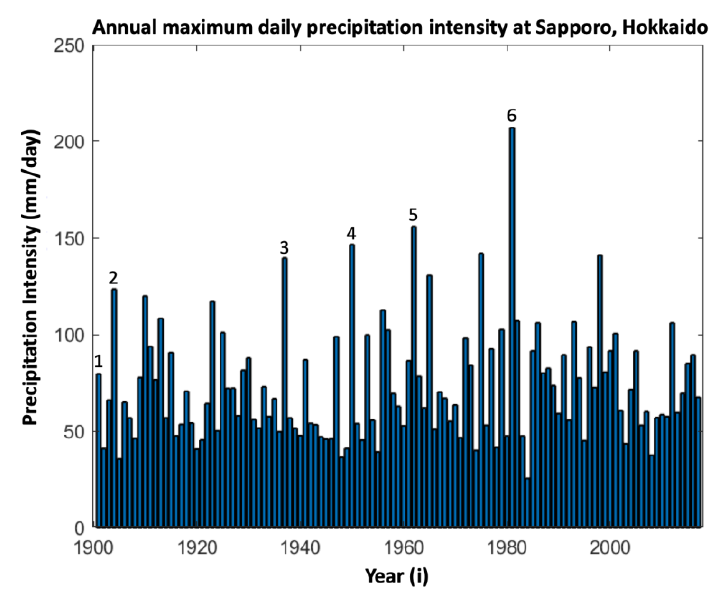
Figure 2. An example of annual maximum daily precipitation at a single rain-gauge station (Sapporo, Hokkaido, northern island of Japan). Number of new records are plotted on the figure.